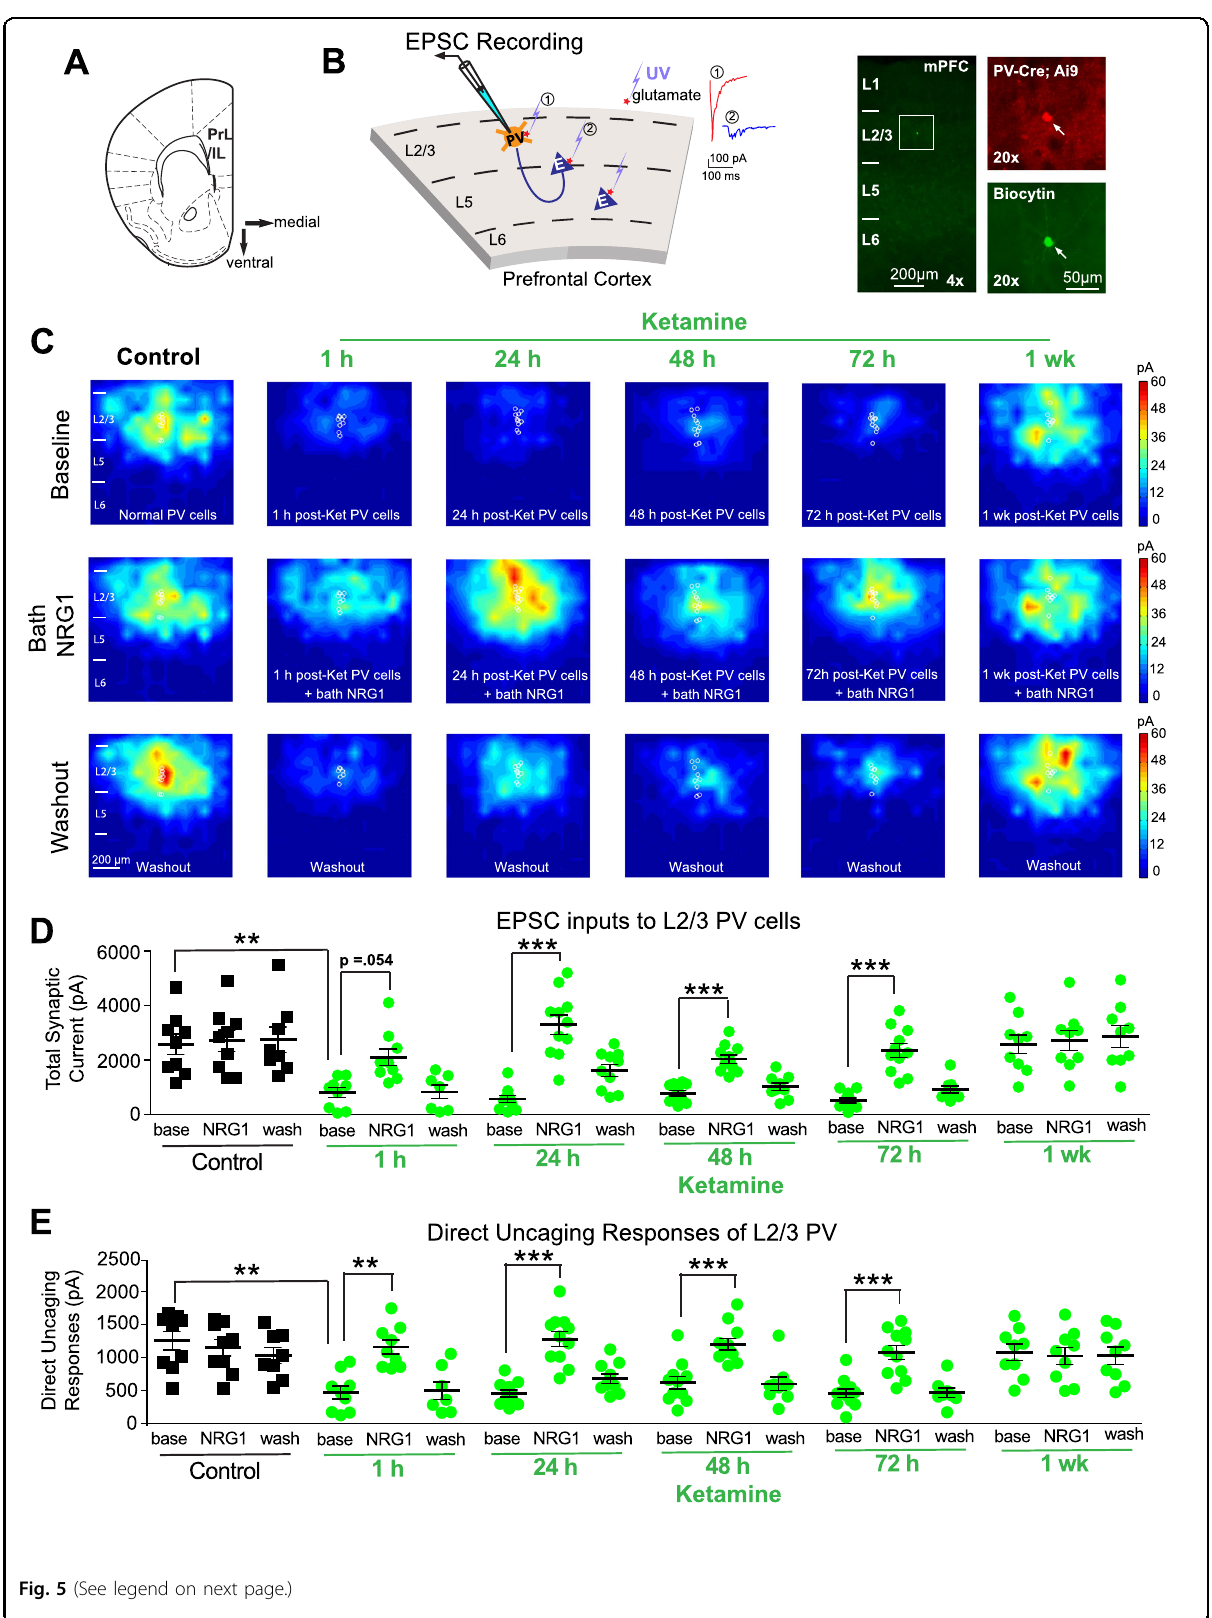
Fig. 5 (See legend on next